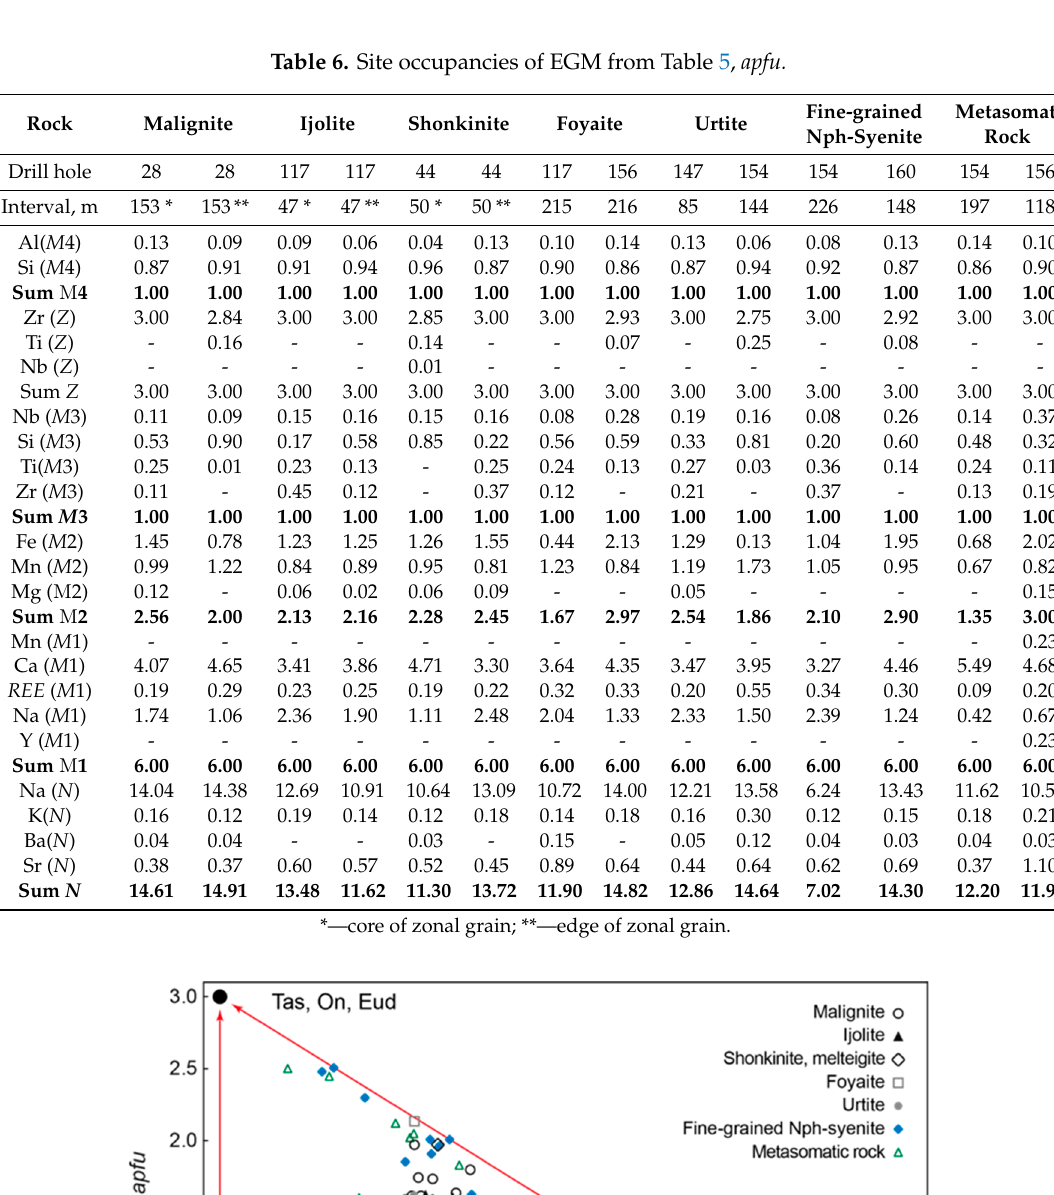
Table 6. Site occupancies of EGM from Table 5, apfu.